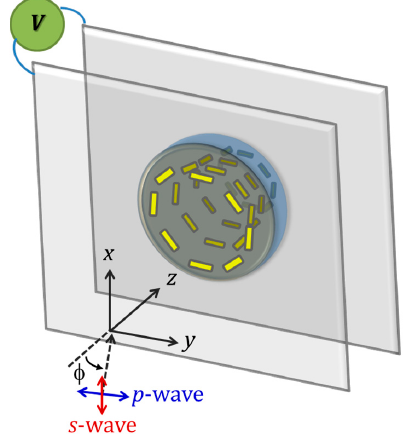
Figure 8. Physical model of the vortex-like director field of LCs (yellow rods: LC molecules) obtained by the driving of a vortex-like turbulence of charge impurity induced by the EHD effect under the action of the low-frequency-applied electric field along the z direction and the confinement of the dome-like boundary of the droplet at the high voltage regime. The bottom of the dome-like morphology of the LC droplet is on the xy plane and the rotational axis of the vortex-like turbulence of charge impurity is along the z axis. φ is the incident angle of probe beam relative to the z axis on the yz plane (plane of incidence).